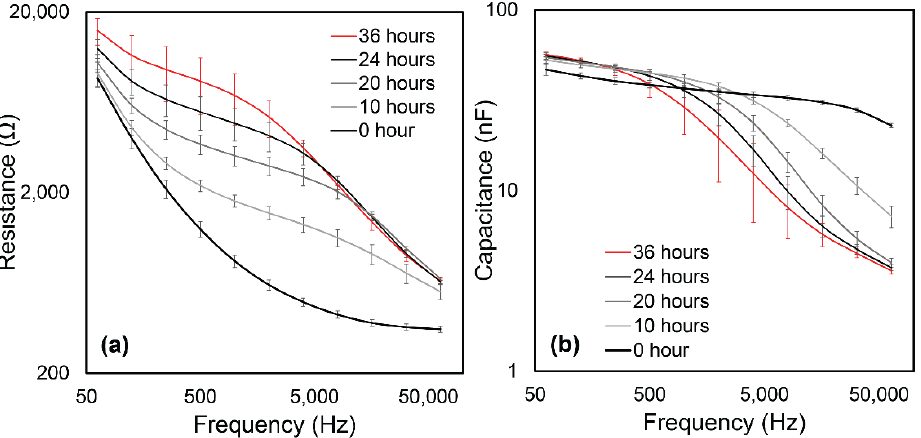
Figure 5. ( a ) Resistance and ( b ) Capacitance evolution curves derived from Figure 4. ( a ) The frequency response of resistance in the middle to low range (1 kHz < f < 10 kHz) is sensitive to the electrical pathway between cells and the channel surface. This evolution demonstrates the creation of cell–cell binding. ( b ) The capacitance at high frequency current ( f > 10 kHz) is sensitive to the current passing through the cell body and quantifies confluence.